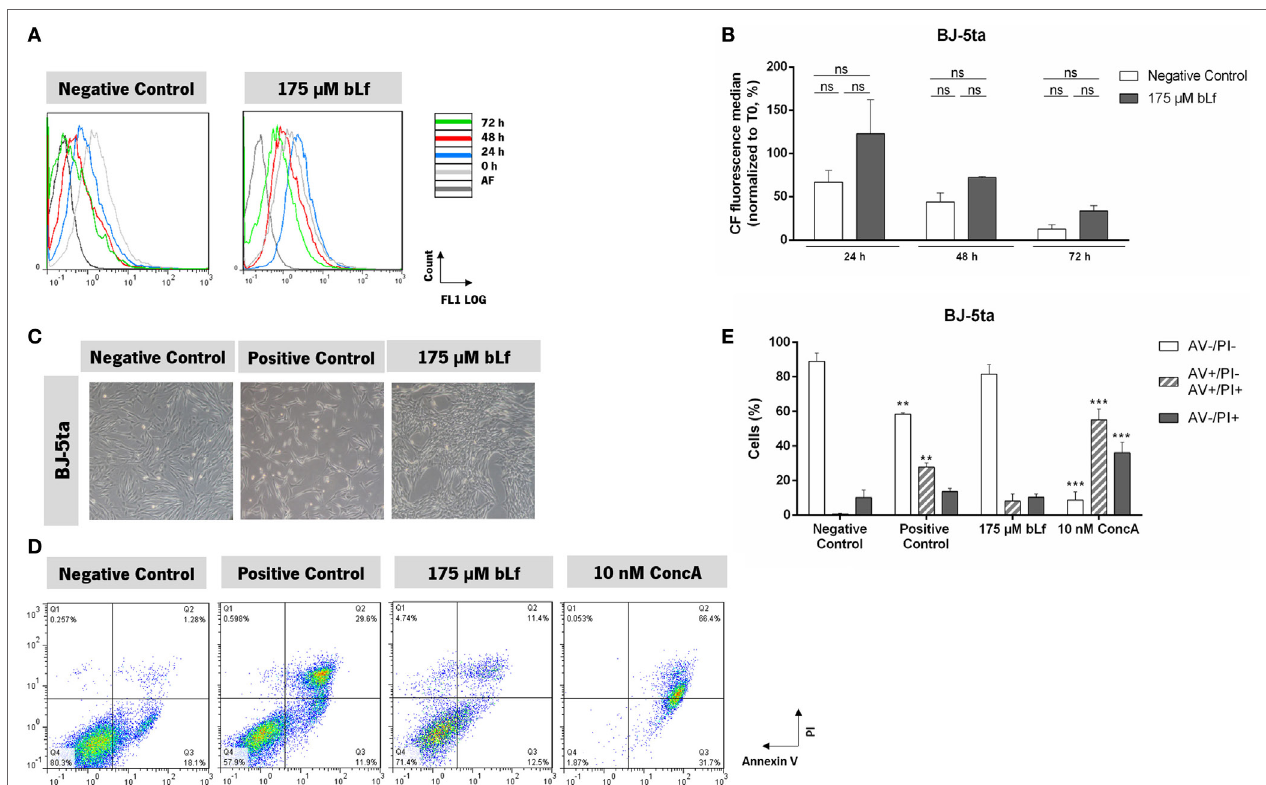
FigUre 3 | Bovine lactoferrin (bLf) does not affect the cell proliferation nor induces cell death on the non-tumorigenic cell line BJ-5ta. (a) Representative histograms of cell proliferation analysis with carboxyfluorescein diacetate succinimidyl ester probe after 0, 24, 48, and 72 h exposure to bLf. Unexposed cells were used as a negative control. (B) Quantification of the carboxyfluorescein median fluorescence values normalized to T0 after 24, 48, and 72 h of exposure. Values represent median ± SD of three independent experiments. ns, non-significant. (c) Representative images of BJ-5ta cell cultures after 48 h of treatment with bLf and etoposide (10 × phase contrast). (D) Exposure of phosphatidylserine induced by bLf or concanamycin A (ConcA) was monitored by AV-FITC/PI staining. Representative histograms of untreated cells (negative control) or treated during 72 h with 175 µM bLf, 10 nM ConcA, or with 60 µM etoposide (used as positive control). (e) Quantitative analysis of the AV/PI assays in panel (D) . Values represent mean ± SD of three independent experiments, ** P < 0.01 and *** P < 0.001 when compared with negative control